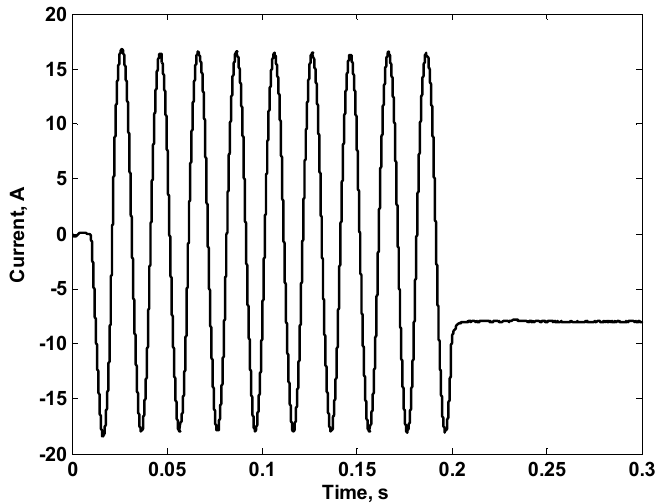
Figure 18. Output Current with − ve DC transfer at Converter Terminals.